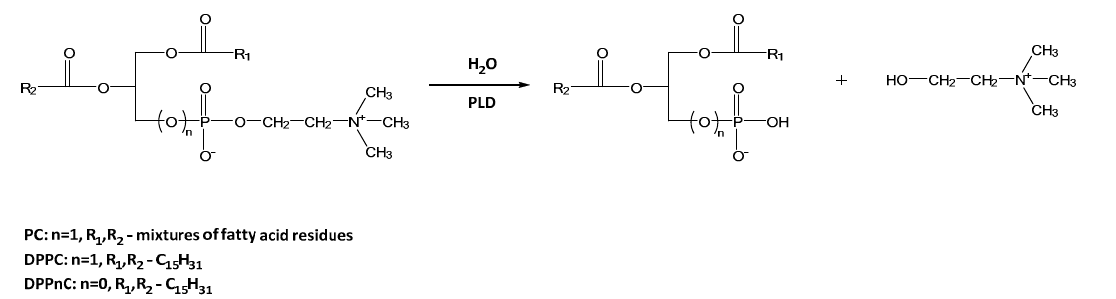
Figure 4. Enzymatic hydrolysis of DPPnC, DPPC and soybean PC by phospholipases D. Results are presented as means ± standard